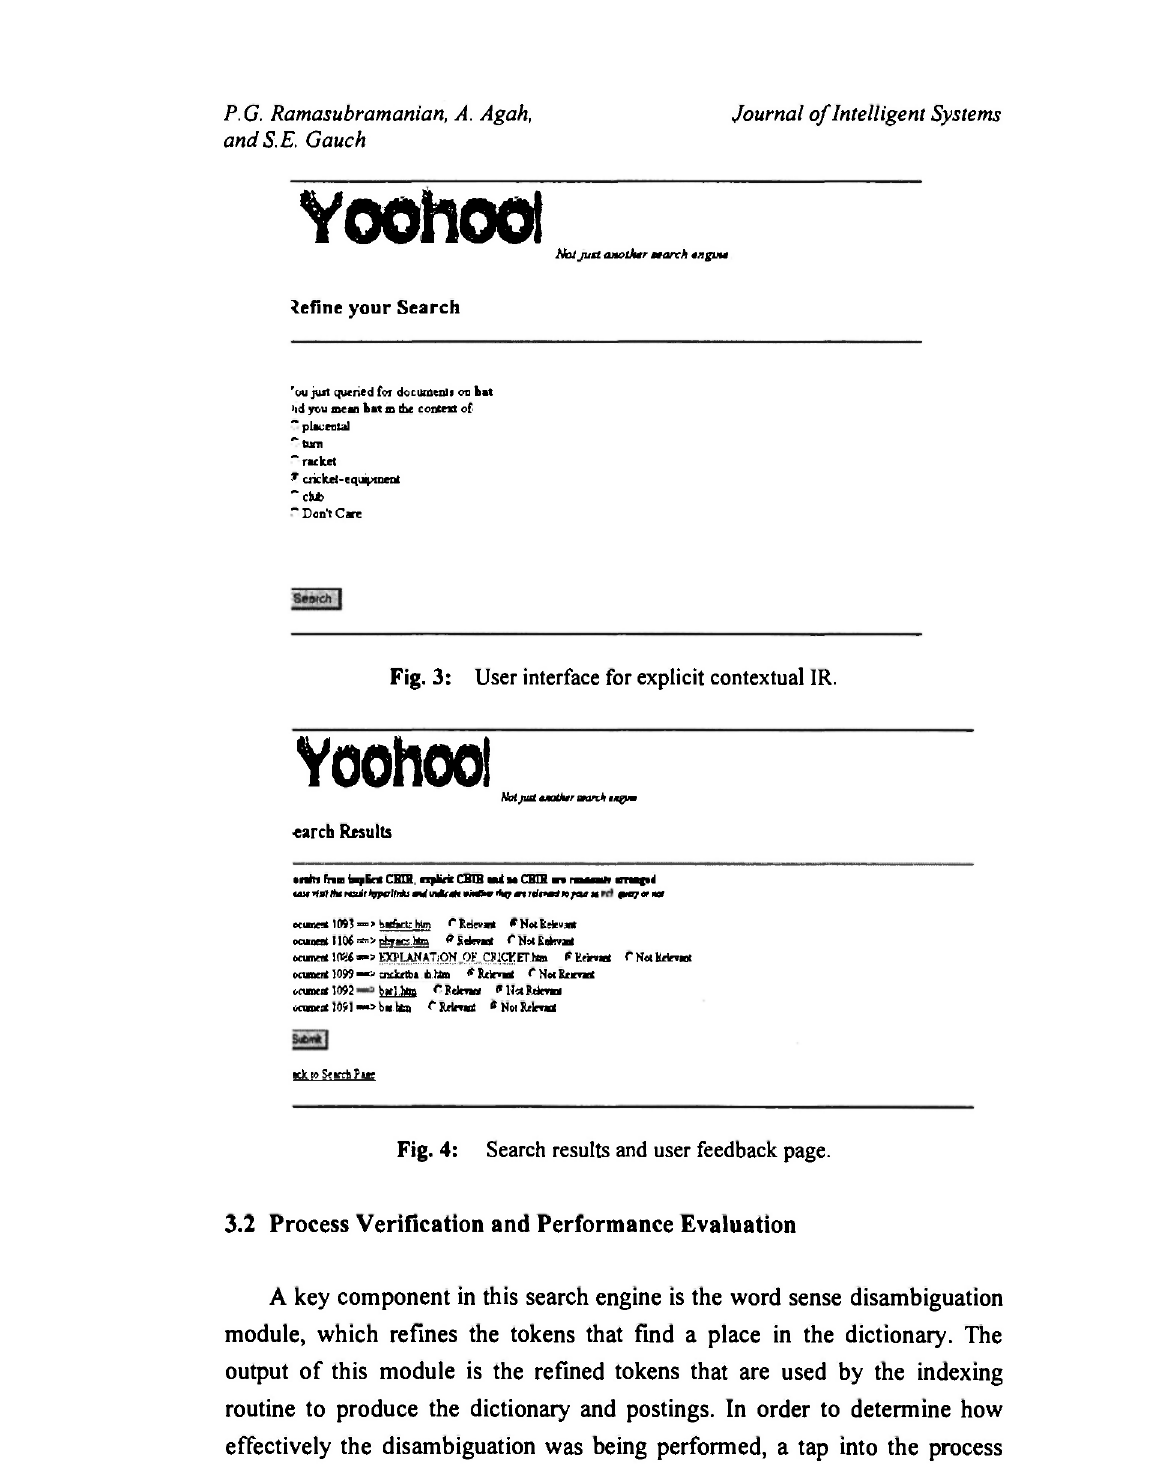
Fig. 4: Search results and user feedback